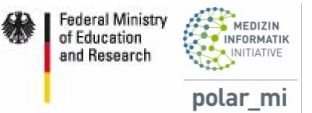
Complete list; Table S3: Translation of German phrases used in the German or Swiss SmPCs translated into English; Table S4: Examples of assigning conditions to severity